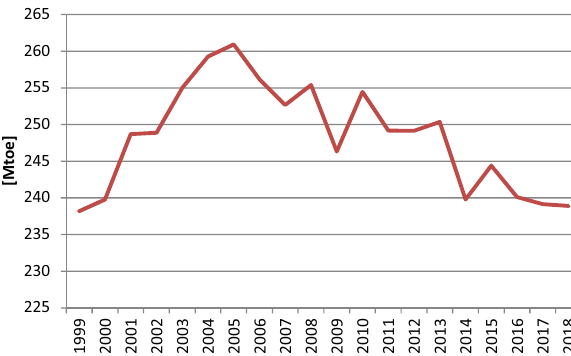
Figure 5: Primary energy consumption in France in the years 1999 – 2018. Source: own work based on ref. [ 5 ] .